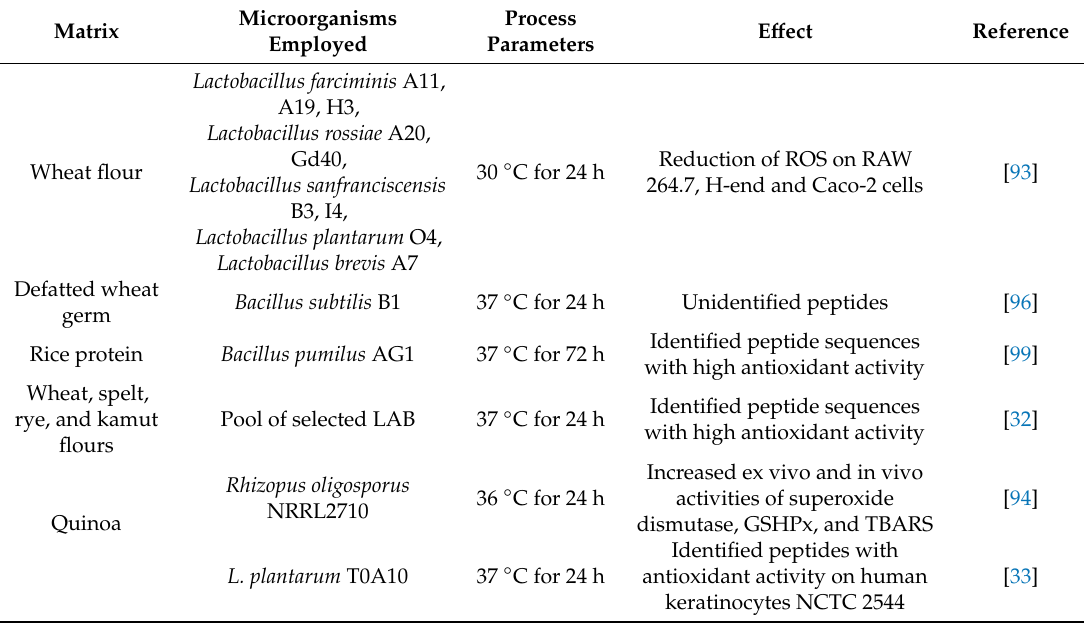
Table 2. Main e ff ect of bioactive peptides and amino acids derivatives on the antioxidant activity of fermented cereals, pseudocereals, and